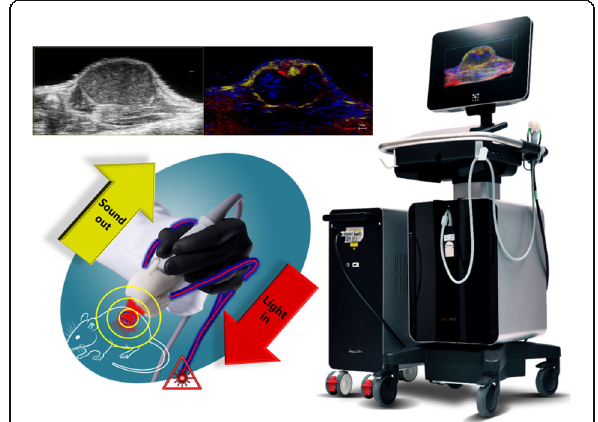
Fig. 1 Schematic of PA/US multimode imaging